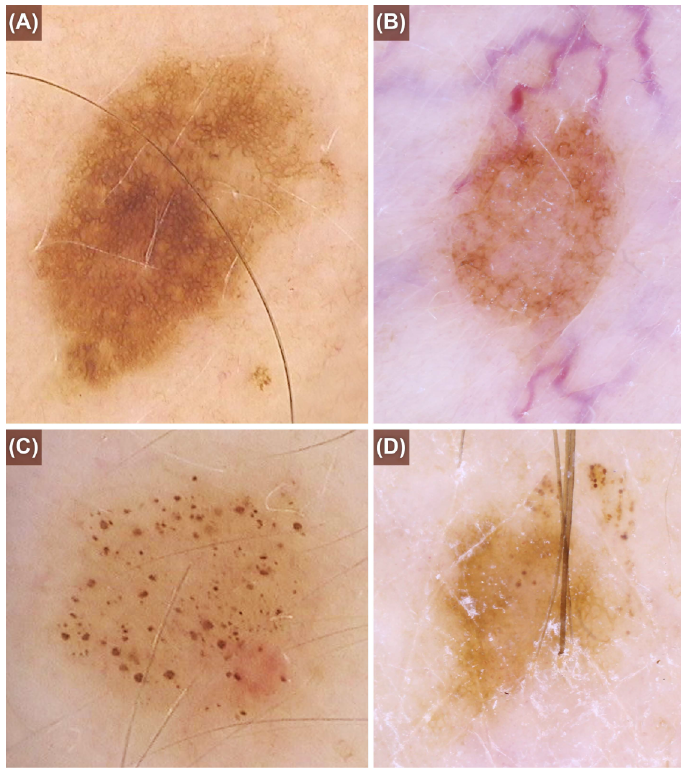
Fig 3. Differencesin old and new BNMS criteria for reticular and globular patterns. Reticular:(a) the new system specifies that lines must create a completenet; (b) lines that form open shapes do not meet the criteria. Globular:(c) globulesmust be present over 1/3 or more of the naevus under the old BNMS system; (d) under the new BNMS system, 3 or more globulesmust be present but the globulescan be confined to a relatively small